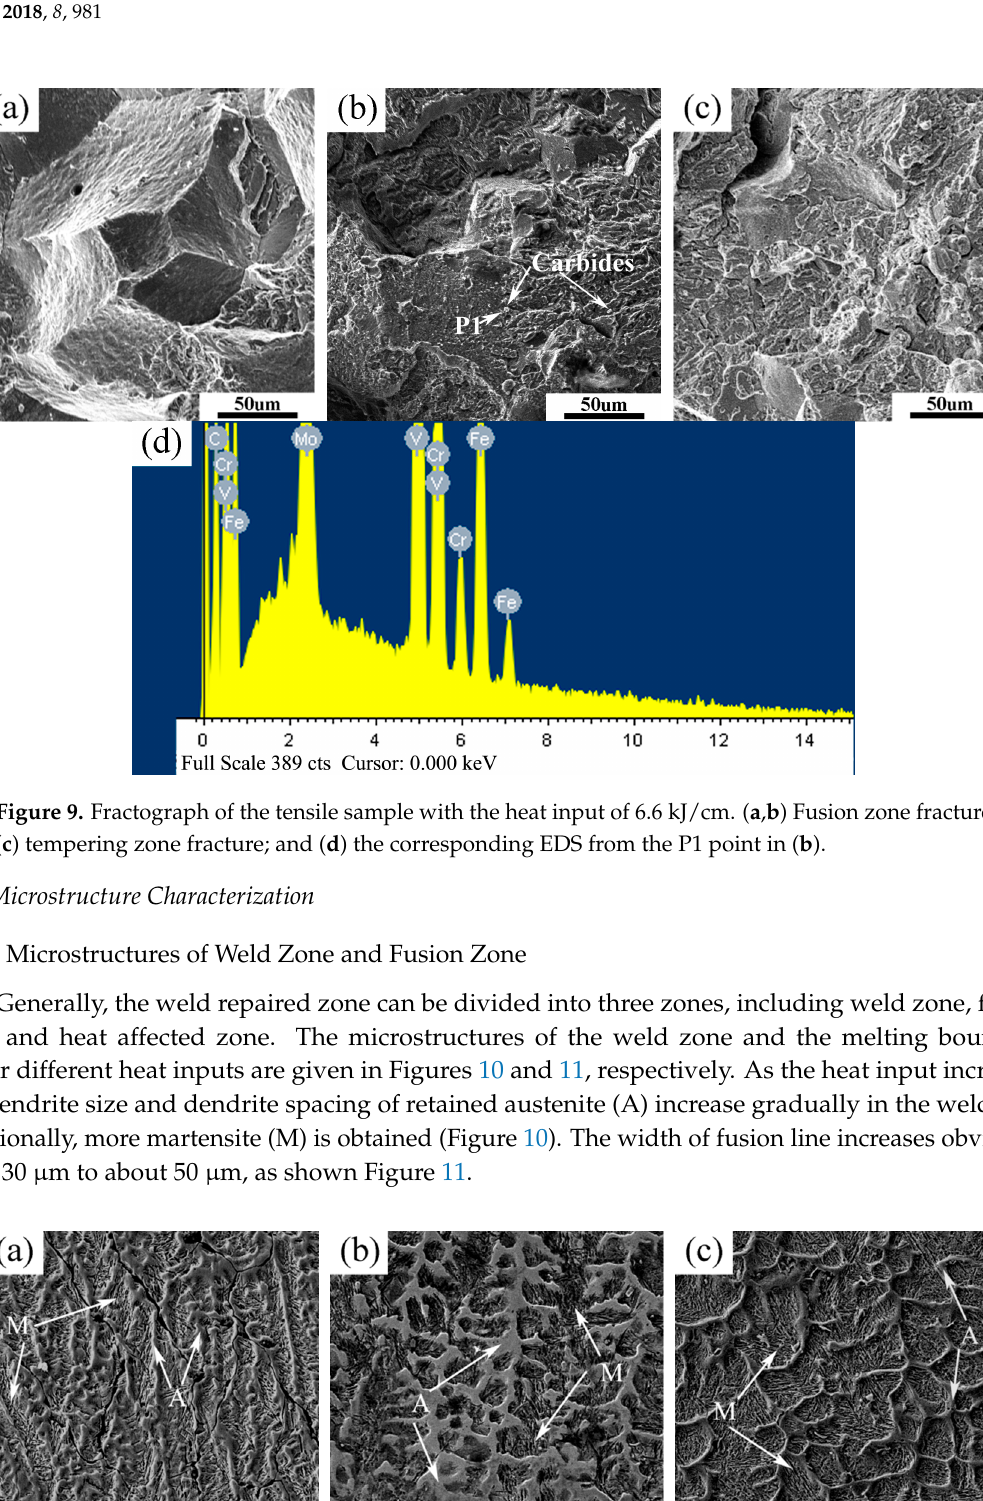
Figure 8. Fractograph of the tensile sample with the heat input of 5.4 kJ/cm. ( a , b ) Fusion zone fracture; and ( c ) tempering zone fracture.